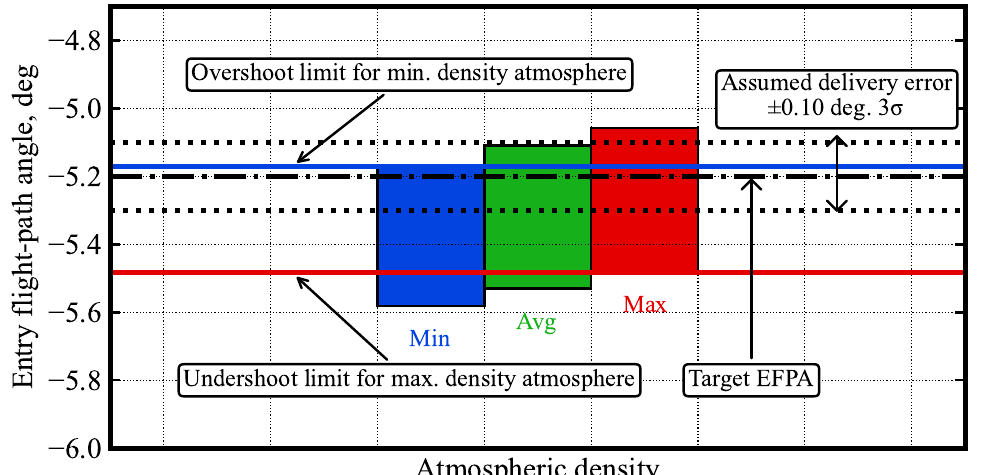
Figure 19. Effect of density variation on Venus aerocapture corridor. The black dash-dot line indicates the selected EFPA, and the black dotted lines indicate the assumed ± 3 σ error.